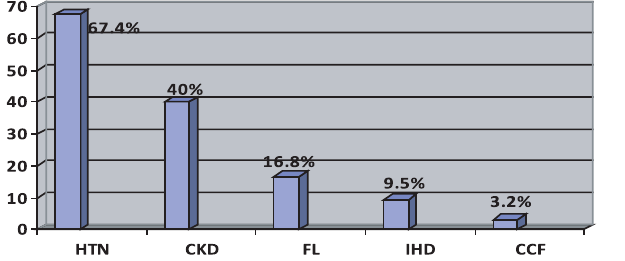
Fig 1. Comorbidities associated with diabetes (n=95)